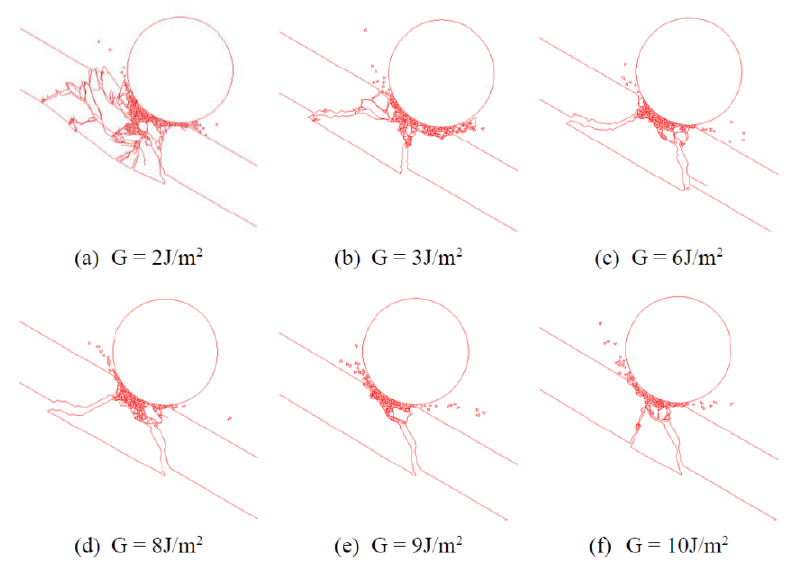
Figure 21. Fracture patterns of the glass with α = 60°, v = 5 m/s and different G at t = 1 ms.